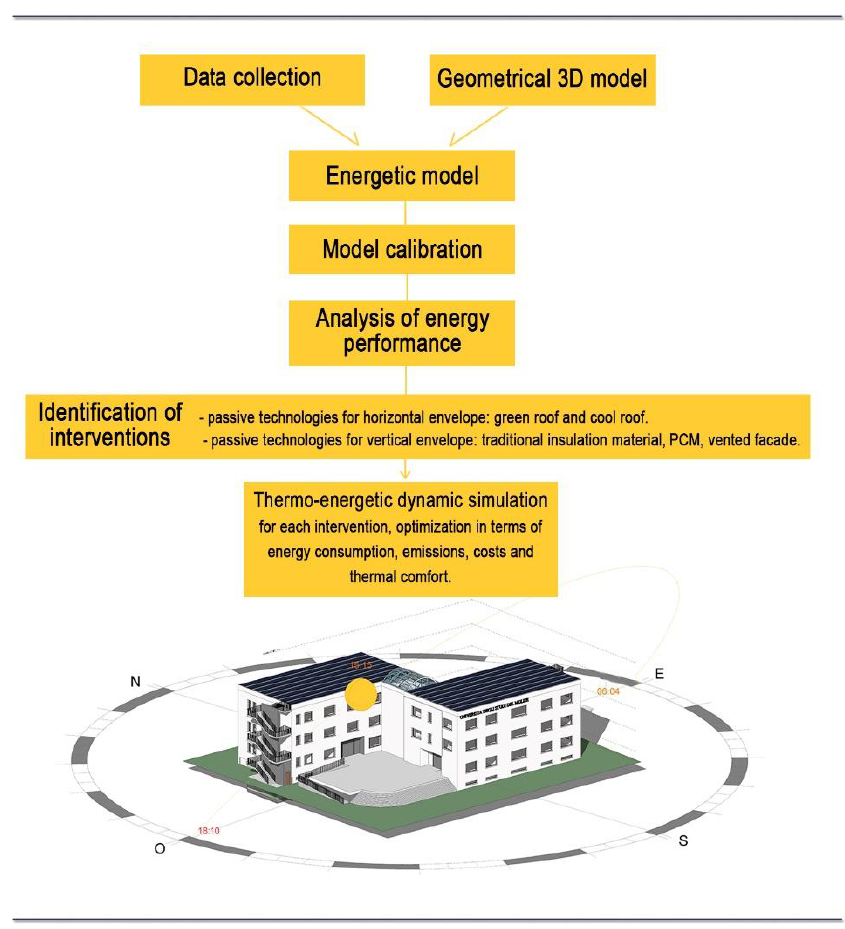
Figure 5. Outline of adopted methodology.